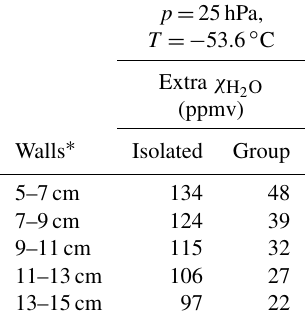
Table 5. Results for ice-layer evolution in the stratosphere due to sublimation–continuation. From 5cm from the rim of the intake tube, the isolated rings become 2cm long down to 15cm from the intake tube rim and the ice layers extending from the intake tube rim increase in length in 2cm steps also down to 15cm from the rim of the intake tube. Only one of the pressure and temperature pairs used in the simulations shown in Table 4 is presented. p = 25hPa, T =− 53.6 ◦ C Extra χ H 2 O